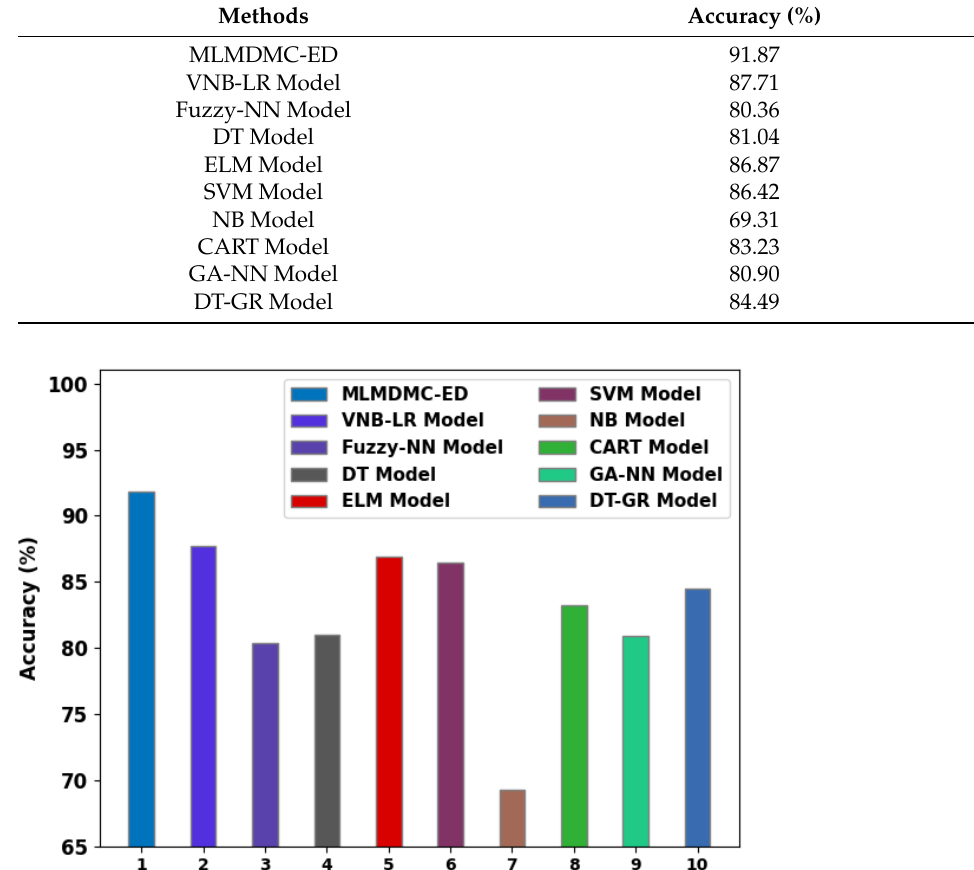
Table 4. Accuracy analysis outcomes of the MLMDMC-ED algorithm and other recent algorithms [29].